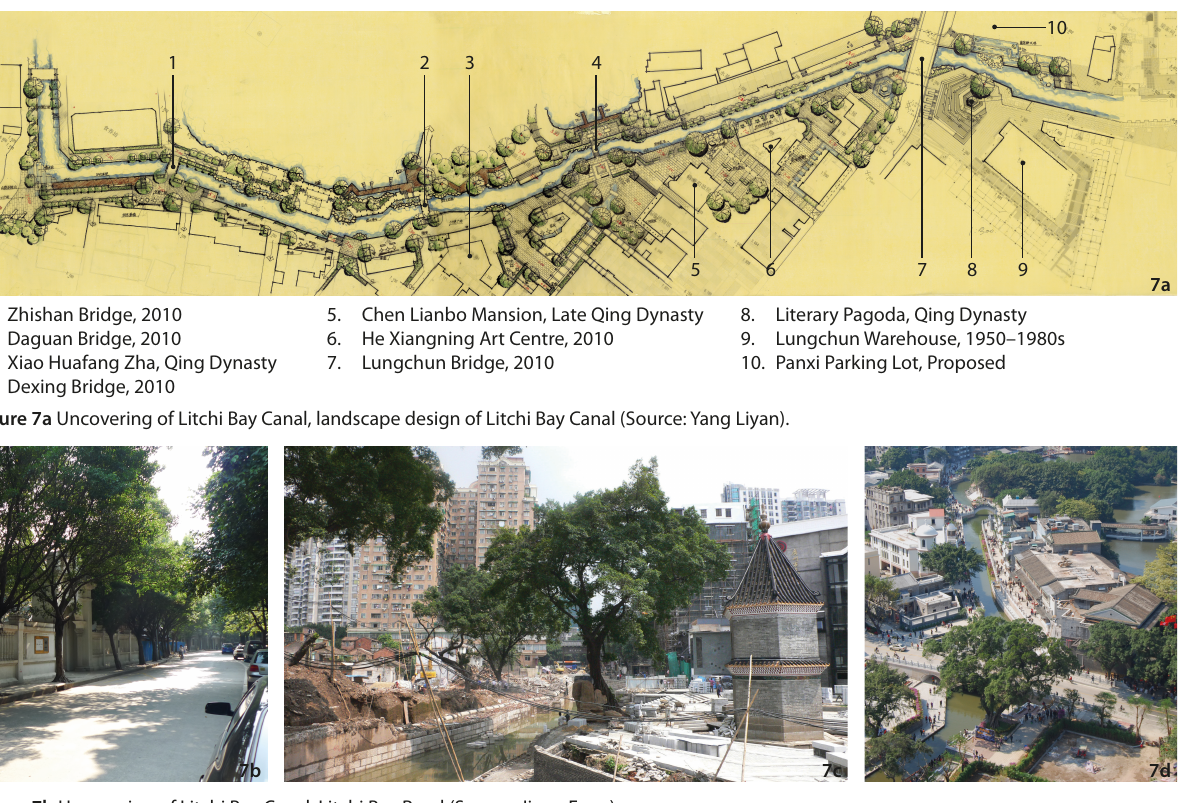
Figure 7b Uncovering of Litchi Bay Canal, Litchi Bay Road (Source: Jiang Feng). Figure 7c Uncovering of Litchi Bay Canal, Litchi Bay Canal under construction (Source: Jiang Feng). Figure 7d Uncovering of Litchi Bay Canal, the revealed Litchi Bay Canal in October 2010 (Source: Guoxiang Huang).